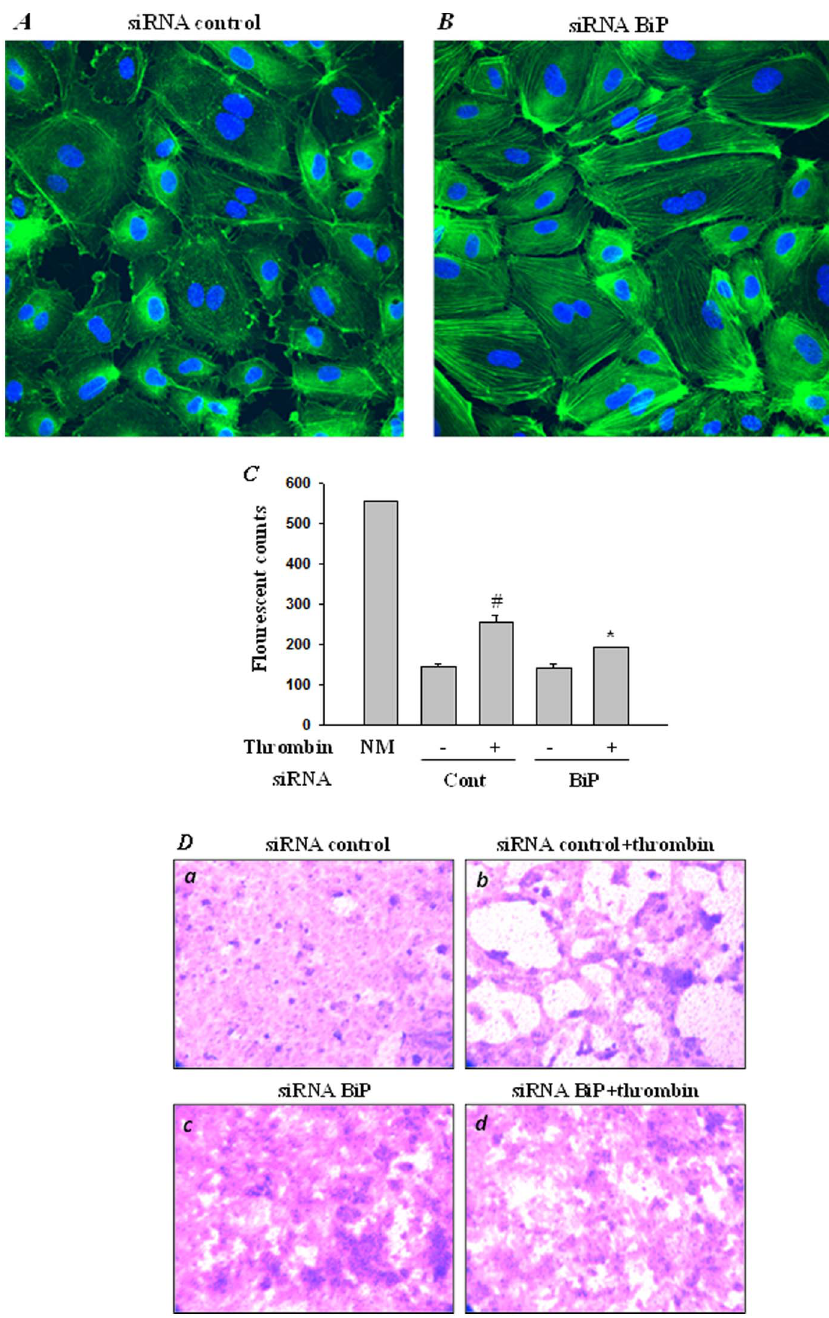
Figure 8. BiP knockdown potentiates actn filment formation and regulates thrombin-induced endothelial permeability. HPAEC were transfected with ( A ) control-siRNA or ( B ) BiP-siRNA using DharmaFect1. After 24–36 h cells were fixed, permeabilized, and stained with Alexa Fluor 488 labeled phalloidin to visualize the actin filaments. Images were analyzed by Fluorescence microscopy. Results are representative of three experiments. ( C ) HPAEC transfected with control-siRNA or BiP- siRNA were seeded at 20,000 cells per transwell insert and cultured for 48 hours. Following this, the confluent monolayer was treated with thrombin (5 U/ml) for 30 minutes. FITC-Dextran permeability testing was done to check monolayer integrity. Permeation was stopped by removing the inserts from the wells. Media from the receiver tray was transferred to a 96 well opaque plate to measure fluorescence. Fluorescent intensities were quantified using a fluorescent plate reader with filters appropriate for 485 nm and 535 nm excitation and emission. The data are the means 6 S.E. (n=3–6 for each condition). # p , 0.05 difference from controls; * p , 0.05 difference from thrombin-stimulated controls. ( D ) Following permeability testing the endothelial monolayer transfected with control siRNA (a & b) or with BiP siRNA (c & d), followed by treatment with thrombin (b & d) or left untreated (a & c) were stained for bright field